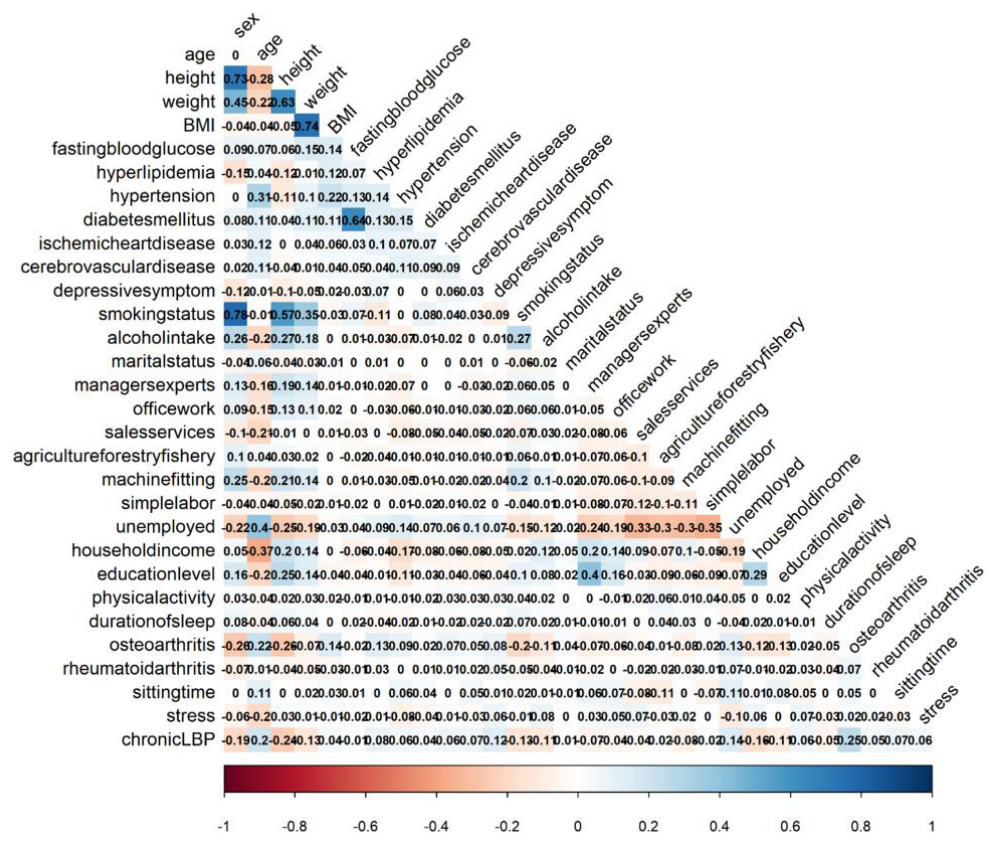
Figure 2. Correlation between variables.